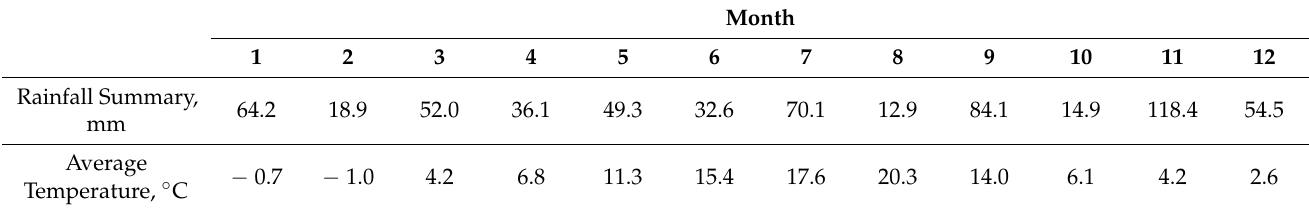
Figure 1. Sampling site location. P1—Gawliki Wielkie, P2—Radzie (sample numbers in parentheses). Table 1. Monthly rainfall and temperatures in the year 2015, in the study